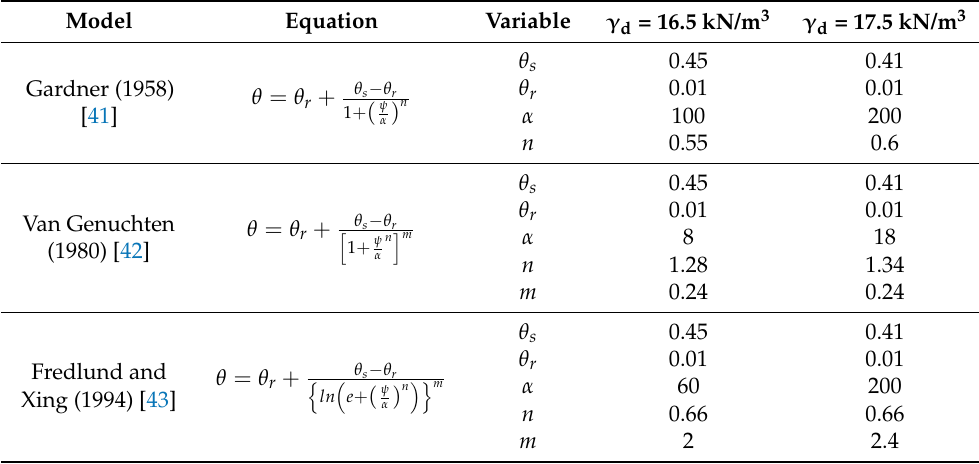
Table 6. SWCC adjustment parameters for each model. θ s and θ r are the volumetric contents of the saturated and residual water,